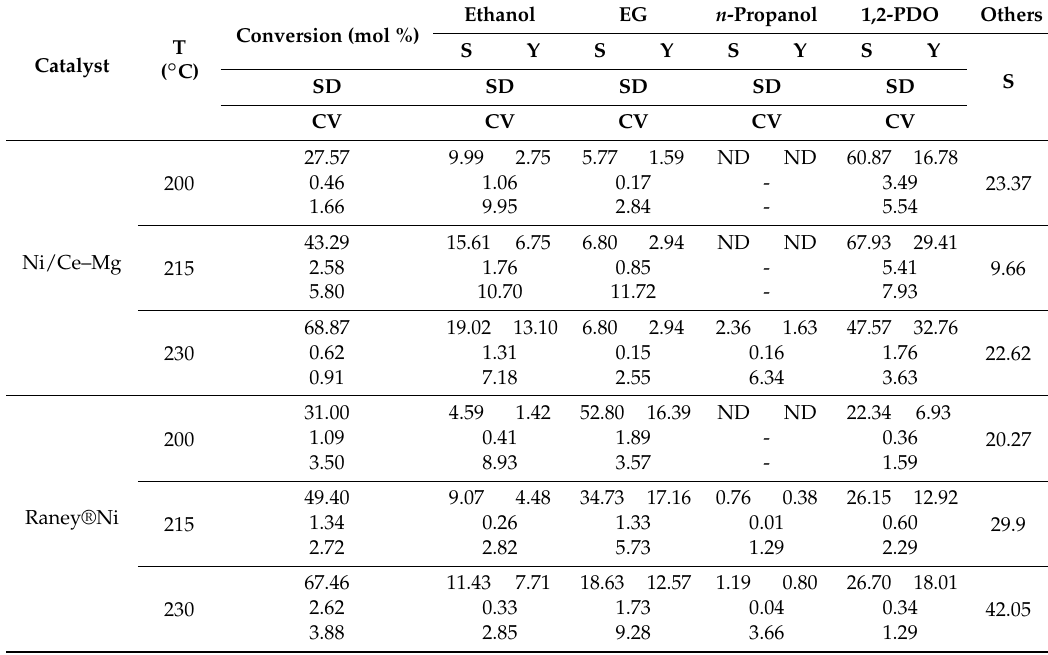
Table 4. Catalyst activity comparison of Ni/Ce–Mg catalyst with Raney ® Ni a,b,c .